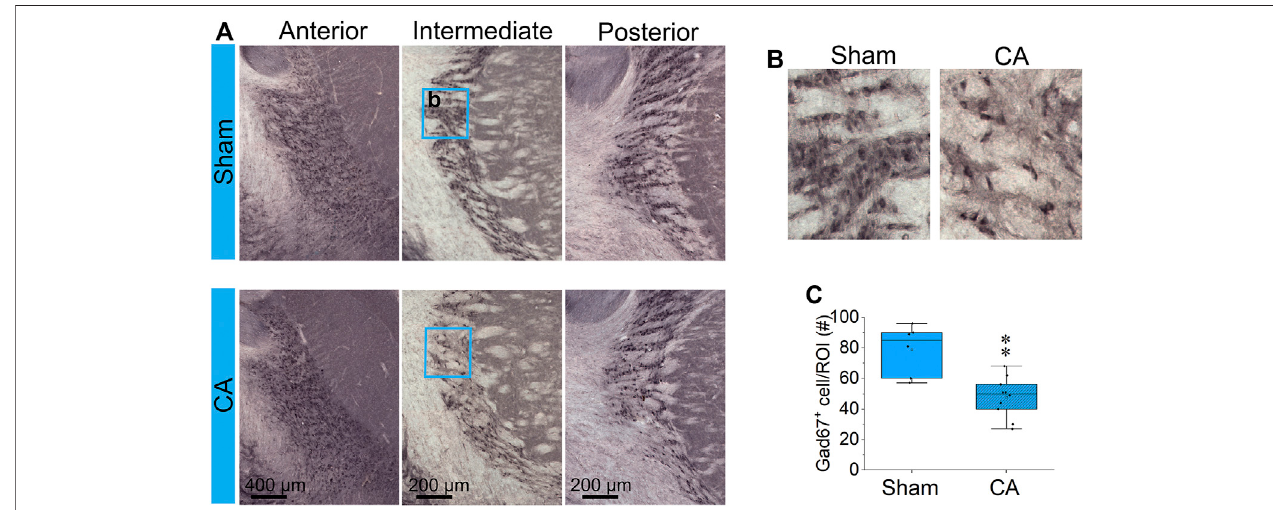
FIGURE 6 | CA reduces GABAergic interneurons in the RT (A) Coronal Gad67-stained sections at anterior,intermediate and posterior RT from one representative brainineachofsham (upperimages) and12.5 minCA+hypothermiarats (lowerimages) .Thebluerectangles(250 × 300 µm)capturethehighmagni fi cationshowed in (B) andanalyzed Gad67 + cellsin (C) .Thereisstatisticallysigni fi cantdecrease inthenumber Gad67-labeled neuronsinintermediateRTbetweenCAgroupcompared with sham-operated group (Nested t -test, pp p < 0.01). Dataare presented as individual values with median and interquartile range from two to three stained slides from each of three sham and 5 CA